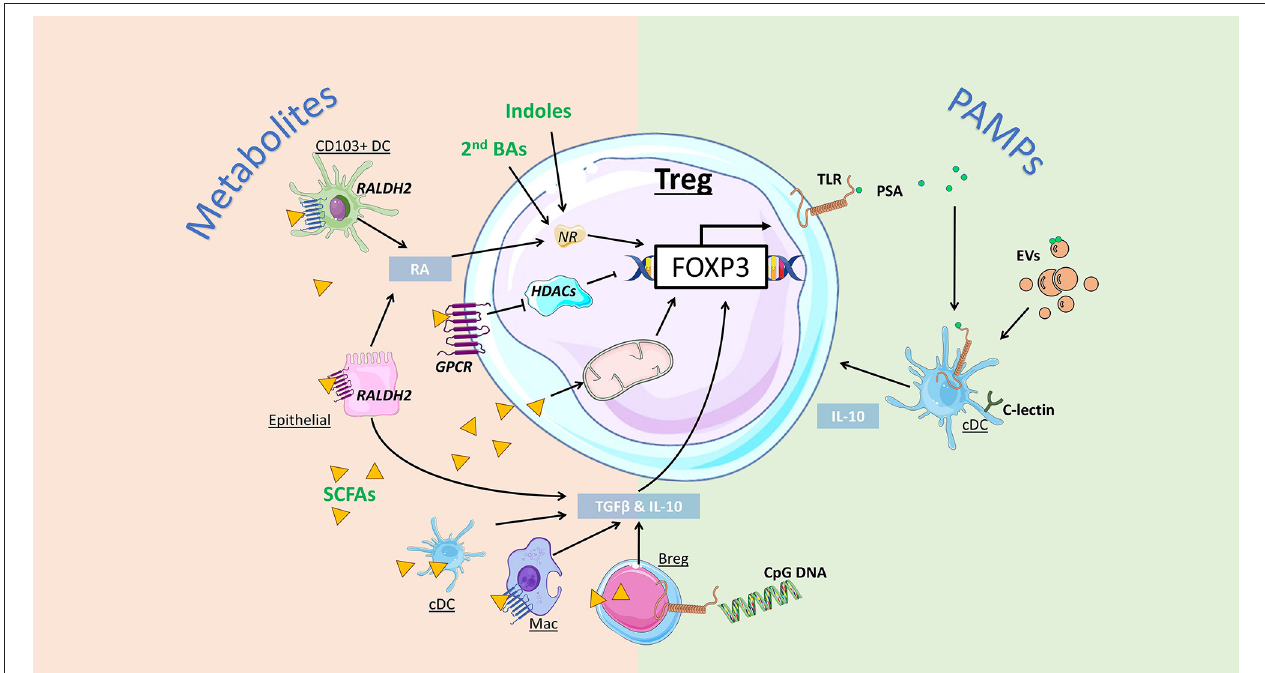
FIGURE 2 | Impact of gut bacteria on regulatory T cell development and function. Microbiota-derived metabolites can regulate Treg development and function via distinct mechanisms. Indoles and secondary bile acids (BAs) can bind to nuclear receptors (NRs) to promote Foxp3 expression and Treg induction. Short-chain fatty acids (SCFAs) can activate G protein-coupled receptors (GPCRs) to promote Treg directly via inhibition of histone deacetylase (HDAC) activity, or indirectly, by enhancing retinal dehydrogenases (RALDH) and retinoic acid (RA) production by CD103 + DCs and epithelial cells. Alternatively, SCFA are directly taken up by cells, including regulatory B cells (Bregs) and conventional DCs (cDCs) to promote expression of Treg-inducing cytokines TGF- β and IL-10. SCFA uptake by T cells can also directly promote Treg induction by increasing mitochondrial activity. Bacterial pathogen associated molecular patterns (PAMPs) can also promote Treg via activation of toll-like receptors (TLR). Bacteroides fragilis- derived polysaccharide A (PSA) promote Treg via TLR signalling on DCs, promoting IL-10 production, as well as Treg-intrinsic TLR2 signals. Extracellular vesicles (EVs) are PAMPs that can bind to TLR and C-lectin expressed by gut DCs and epithelial cells, triggering the release of Treg-inducing cytokines IL-10 and TGF- β